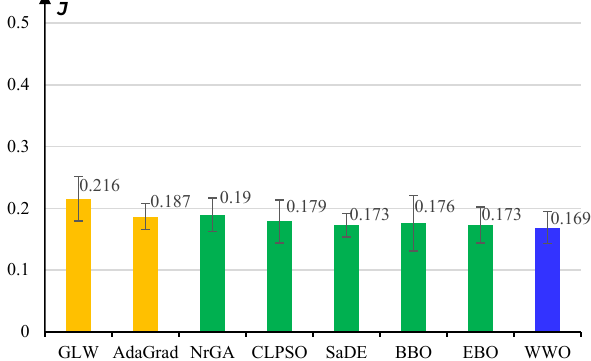
Figure 4. Average reconstruction errors and standard deviations of the comparative algorithms for pretraining the middle group-specific layers of the Behavior Learner